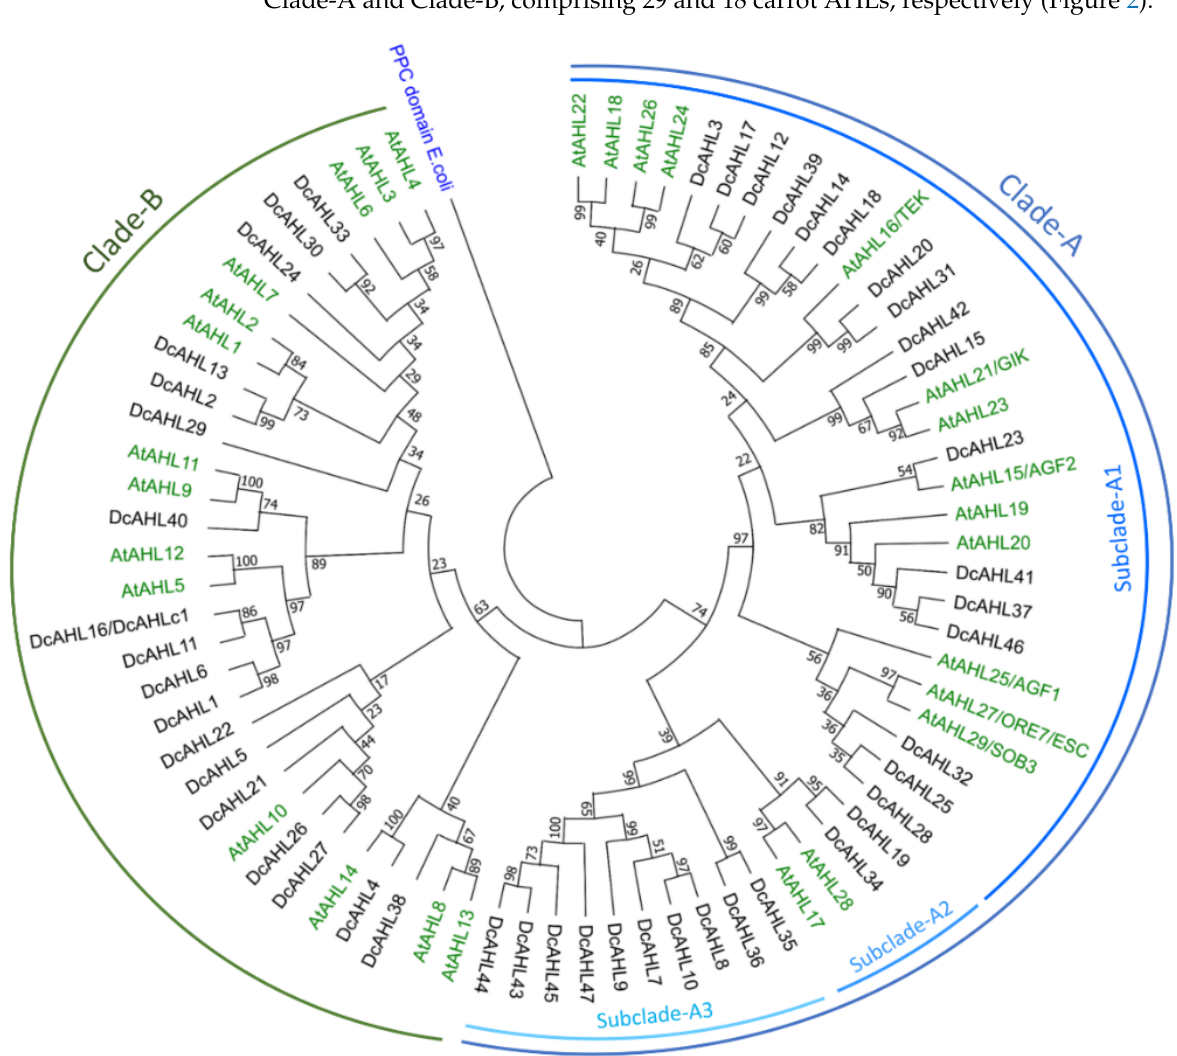
Figure 2. Maximum likelihood tree (1000 bootstrap replicates) of AHL proteins in carrot (black) and A. thaliana (green); PPC domain from E. coli (blue) was used to root the tree.